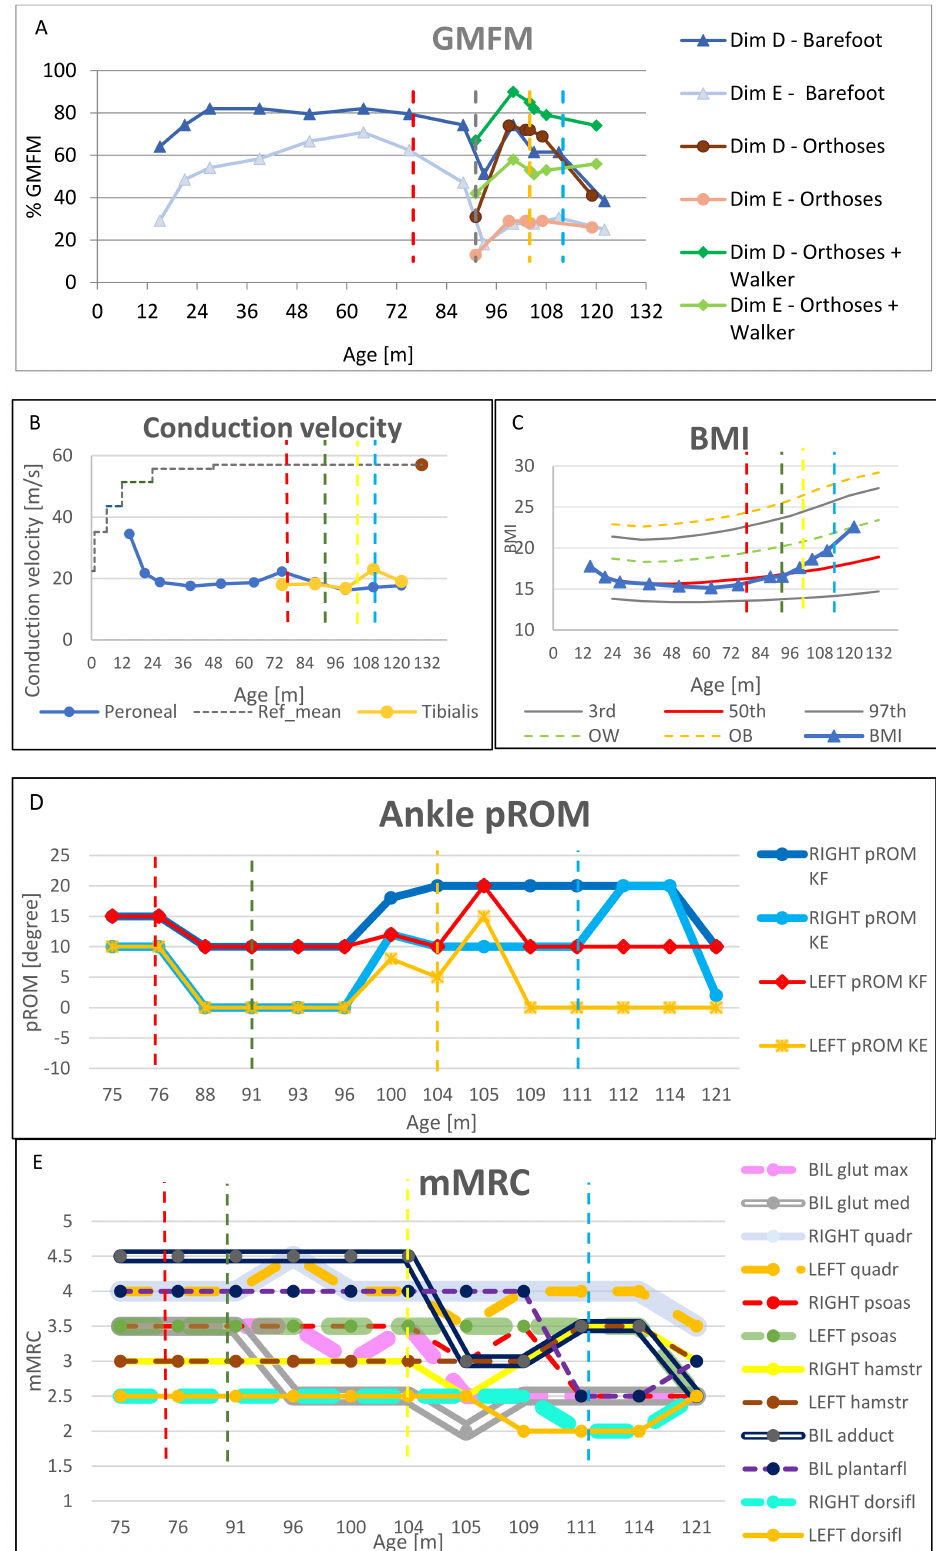
Figure 2. Clinical and instrumental assessments performed over the follow-up period, at different months of age. Time at which interventions and fracture occurred is represented with vertical dot lines: respectively, AFO in red, surgery in green, botulinum in yellow, and tibial fracture in light